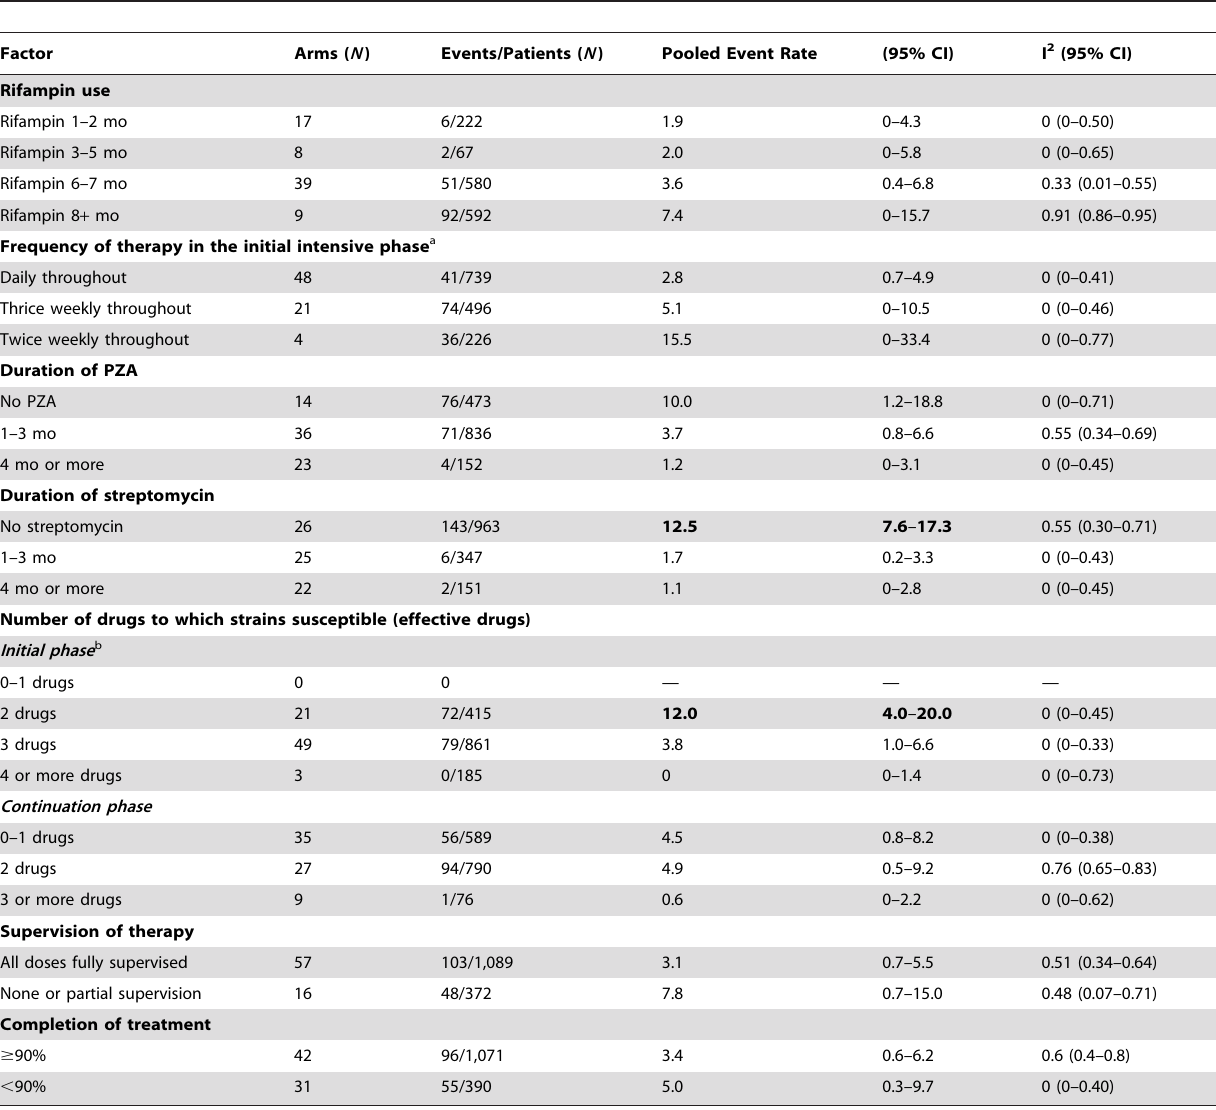
Table 5. Stratified analysis of covariates associated with TB treatment outcomes in RCT of patients with INH resistance in new or previously treated cases: Acquired drug resistance in isoniazid